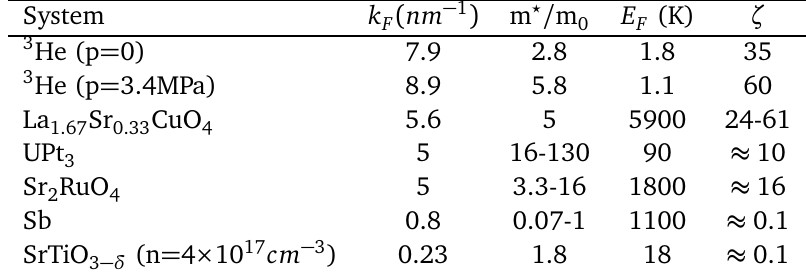
Table 1: 3 He and heavily-doped LSCO compared to heavy-fermion UPt [ 22 ] , semi-metallic antimony [ 48, 49 ] and dilute metallic correlated oxide Sr RuO 2 4 strontium titanate [ 20 ] . Note the exceedingly large normalized amplitude of ζ in LSCO. UPt and Sr RuO despite their larger mass enhancements have smaller ζ 3 2 4